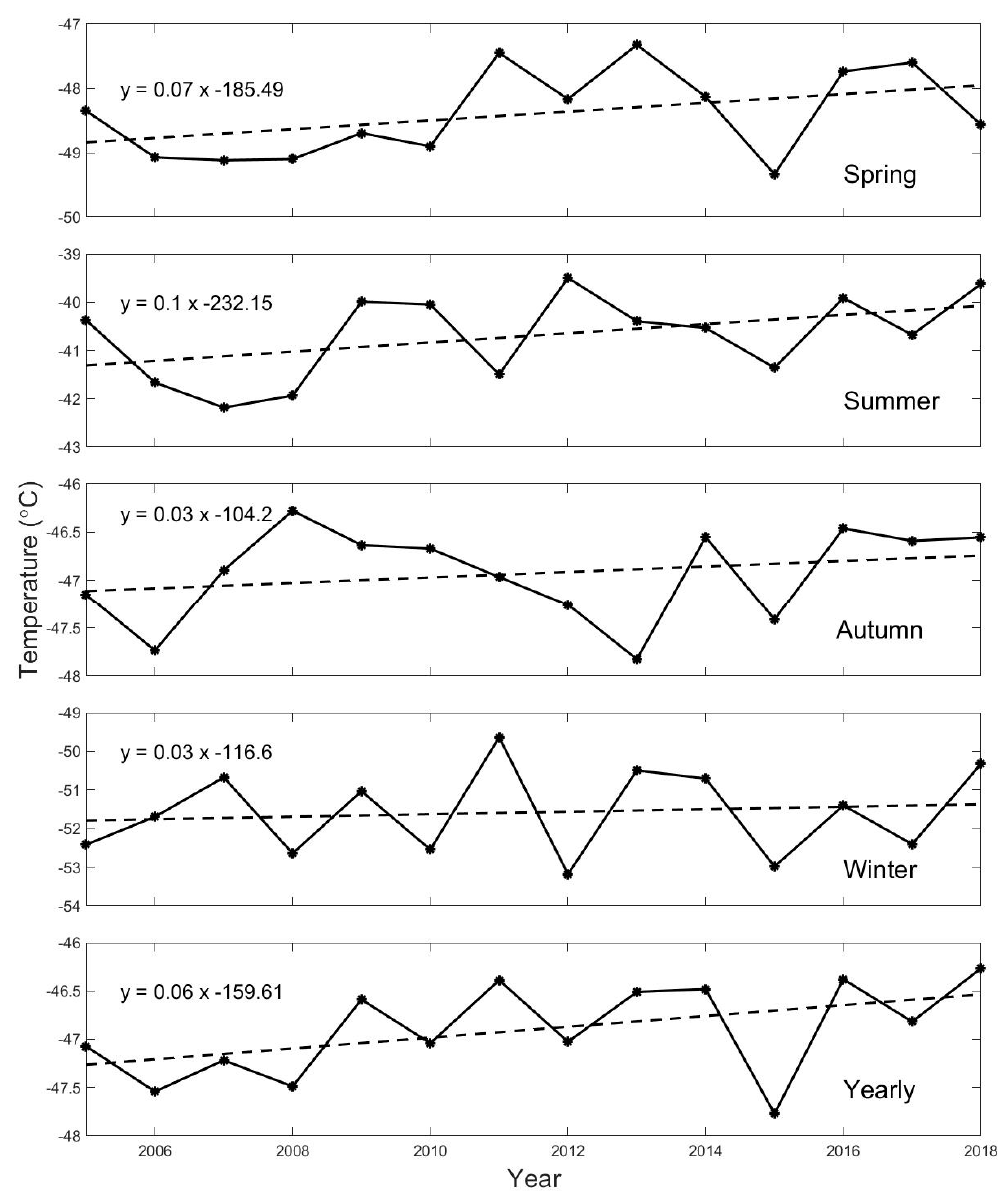
Figure 7. The seasonal and yearly means of temperature within the troposphere (from the surface up to 10 km amsl) during 2005–2018 (the real lines). Linear fitted lines (the dashed lines) and the corresponding equations are also presented.